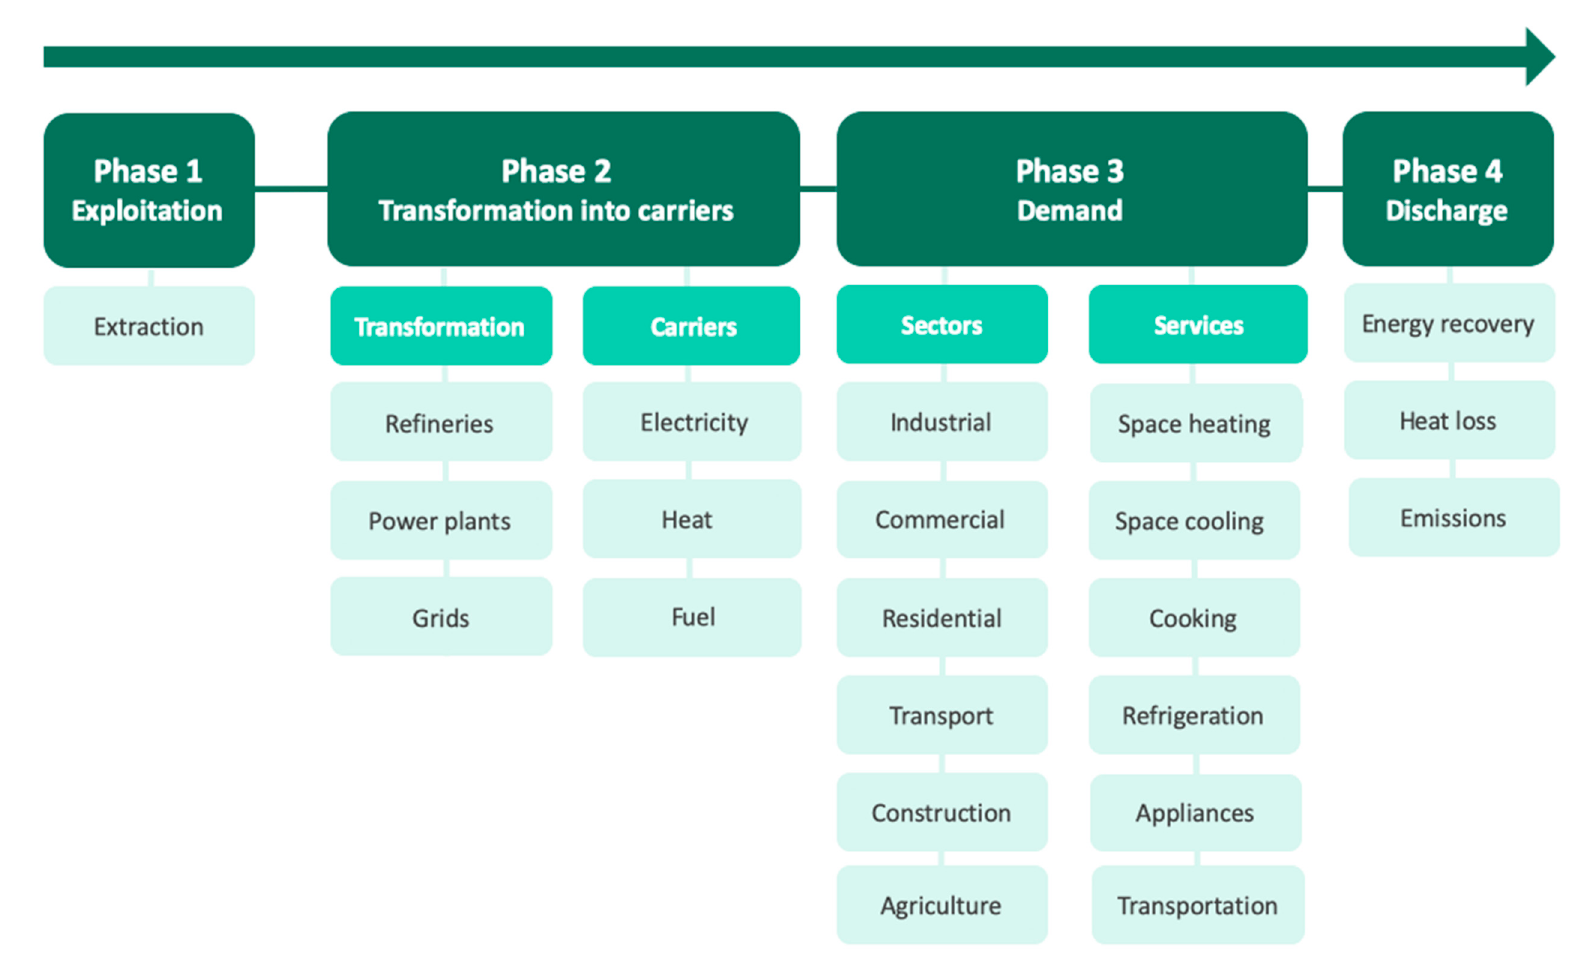
Figure 1. The urban energy system. Sources: Adapted from Carreón and Worrell [20], Chen and Chen [27], and Zhang et al. [28] .